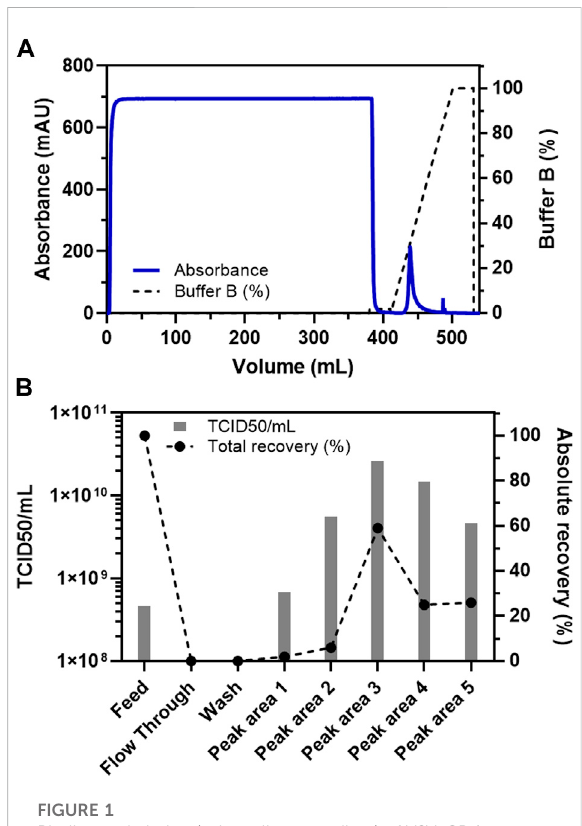
FIGURE 1 Binding and elution (using a linear gradient) of VSV-GP from the crude feed on Sartobind S membrane adsorber. (A) Chromatogram for the puri fi cation of VSV-GP using Sartobind S membrane adsorber column. (B) TCID 50 -based infectivity assay for various fractions obtained during puri fi cation of VSV-GP in (A)